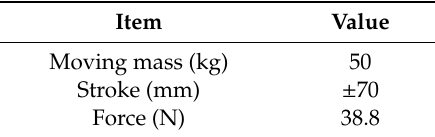
Figure 5. AMD assembly: ( a ) AMD spring, ( b ) AMD frame, ( c ) linear motor, and ( d ) AMD. Table 3. Specifications of the AMD.